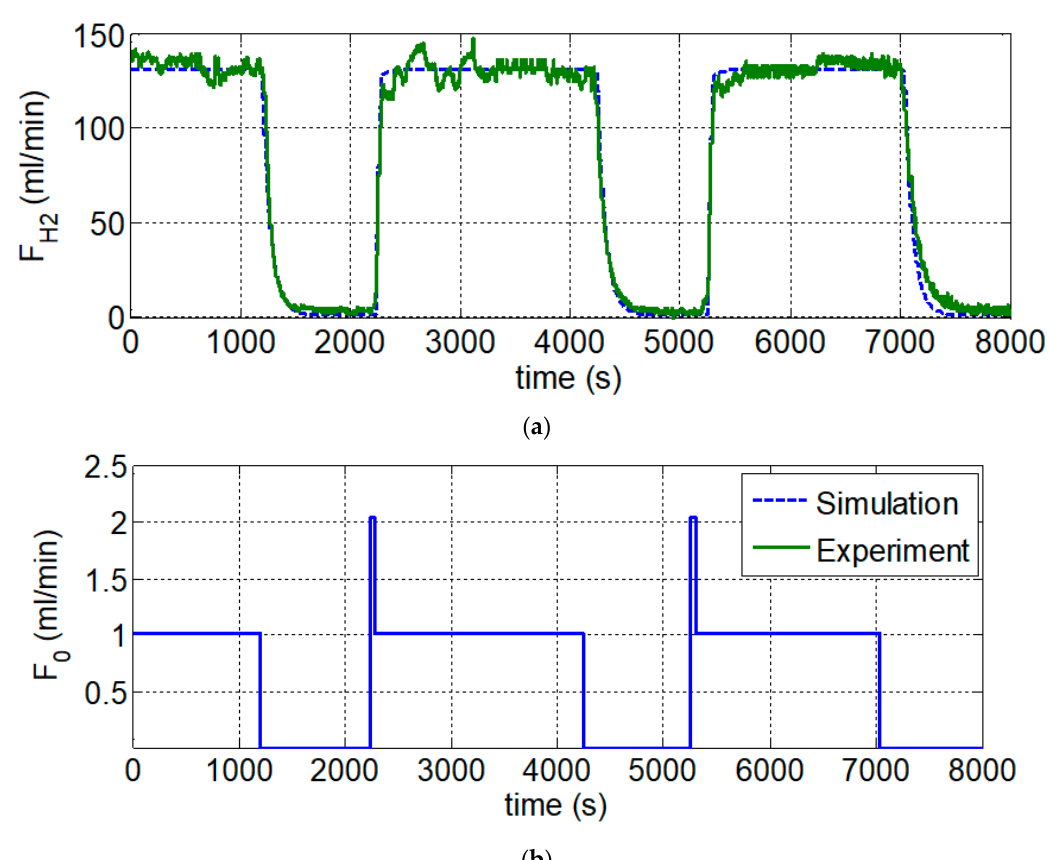
Figure 10. Typical power requirements for different activities, namely; computer in use, sleep mode and shut down ( a ) hydrogen generation flowrate, ( b ) feed flowrate.